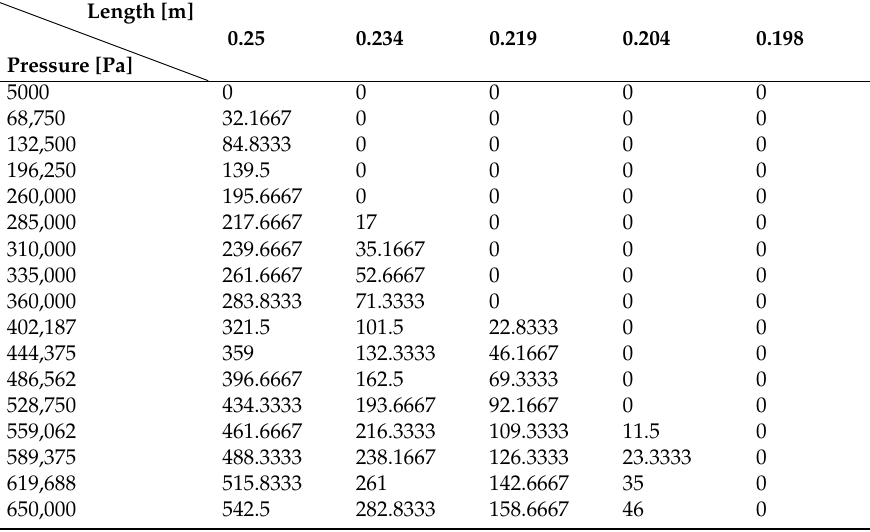
Table A2. Measured force map of a Festo DMSP-10-250 in [ N ]